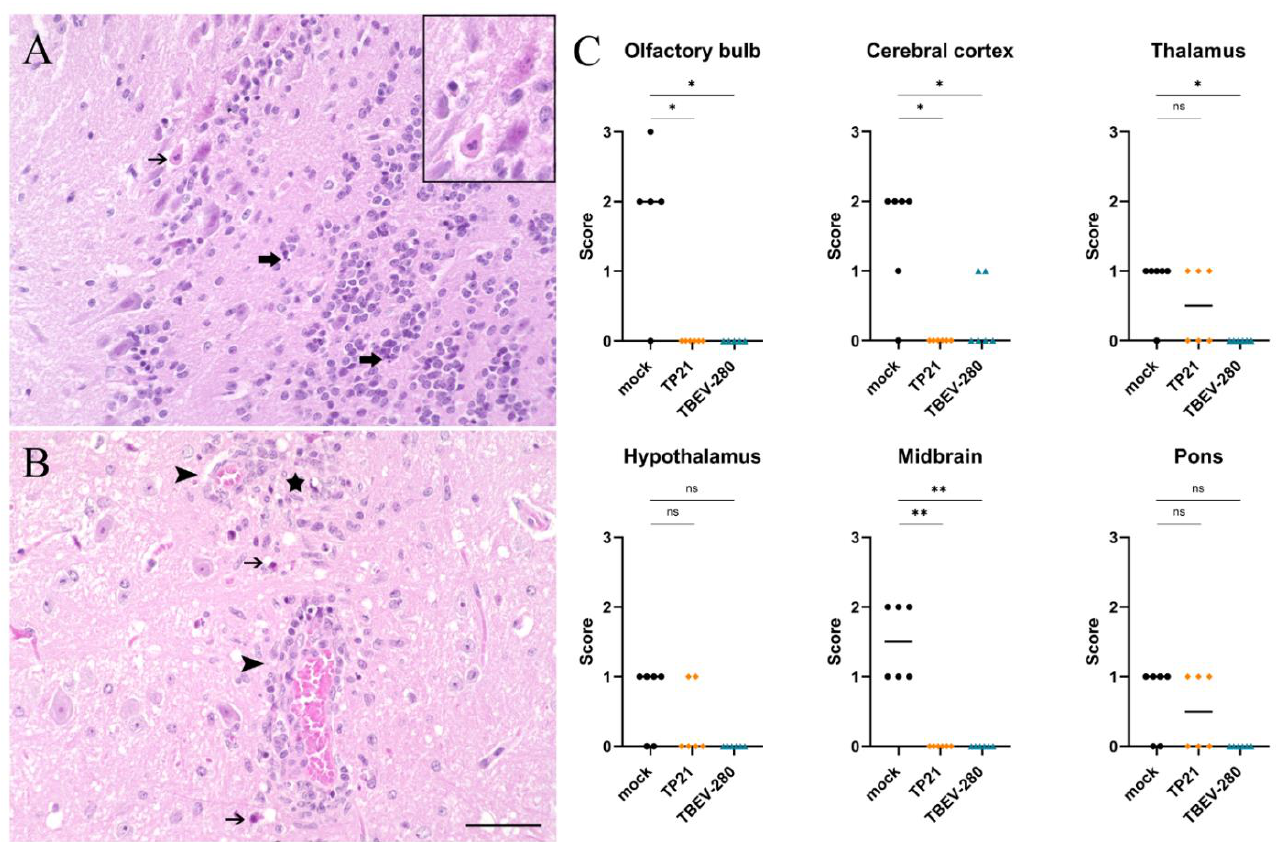
Figure 4. Assessment of neuronal damage in brain following TBEV-Hypr challenge. Representative images of HE staining from olfactory bulb ( A ) and thalamus ( B ) of mock immunized and TBEV-Hypr infected mice demonstrating neuronal necrosis (thin arrows), inflammation (arrow heads), cellular debris/pyknotic nuclei (thick arrows), and gliosis (star) are shown here; scale bars 50 µm. ( C ) Neuronal necrosis in different regions of brain of mock (●), TP21 ( ) and TBEV-280 ( ▲ ) immunized and TBEV-Hypr infected mice ( n = 6) were scored on a scale of 0–3 (see methods). Each dot represent individual mice, bars indicating mean value (* p < 0.05, ** p < 0.01, ns = not significant).